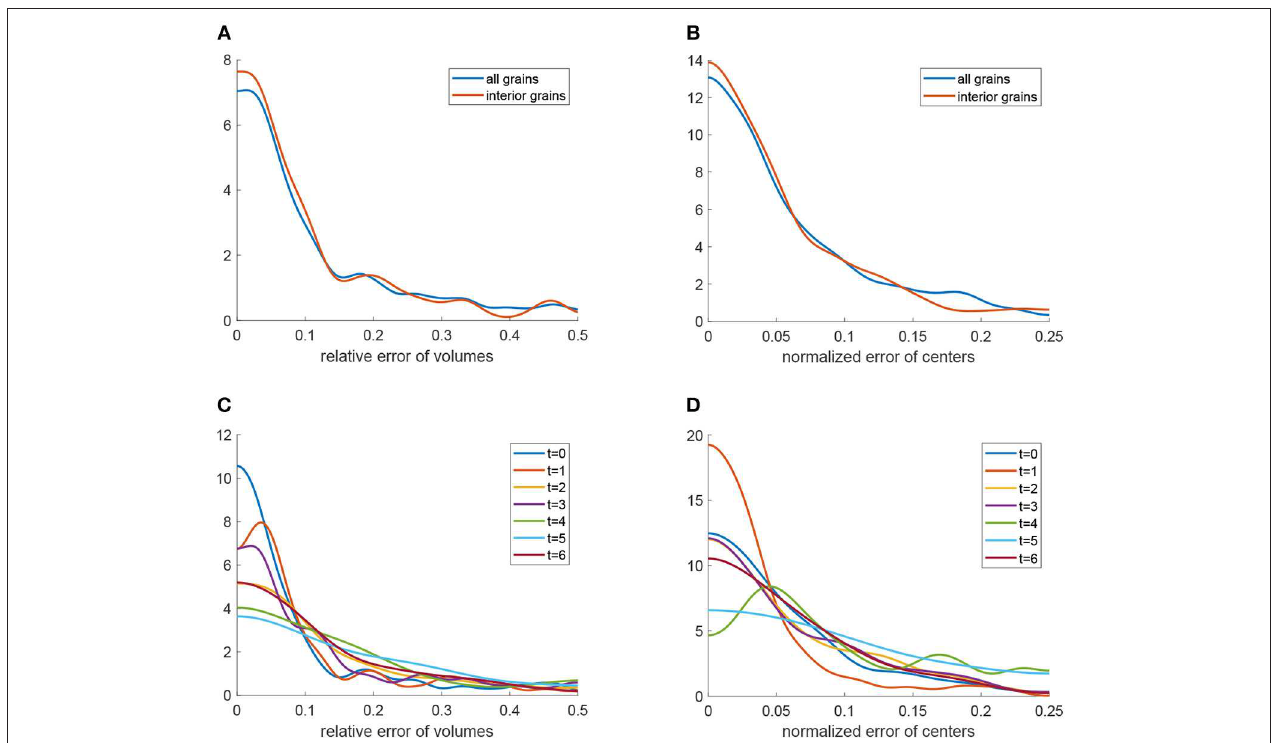
FIGURE 12 | Quantitative analysis of the segmentation procedure based on the 3D U-Net: (A) Kernel density estimation (blue) of relative errors in grain volume. The red curve is the density of relative errors in volume under the condition that the grain is completely visible in the cylindrical sampling window. (B) Kernel density estimation (blue) of normalized errors in grain barycenter location. The red curve is the density of the normalized error in barycenter location under the condition that the grain is completely visible in the cylindrical sampling window. (C) Kernel density estimation of relative errors in grain volume obtained by the segmentation procedure for each measurement step t = 0, ... ,6. (D) Kernel density estimation of normalized errors in grain barycenter location obtained by the segmentation procedure for each measurement step t = 0, ...